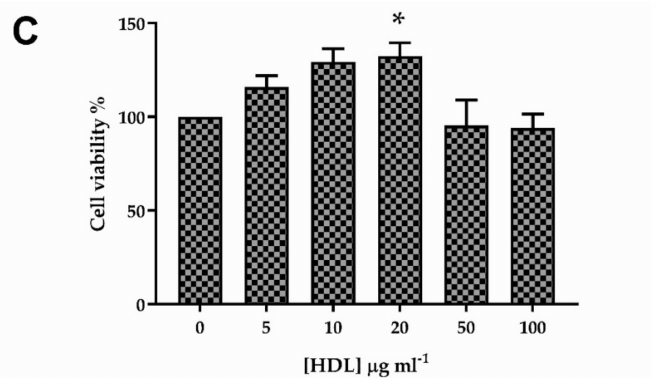
Figure 1. The effects of treatment (24 h) with HDL (0–100 µ g mL − 1 ) on the conversion of MTT to formazan by HKn, HDFn and HDFa are shown in ( A – C ), respectively; data in each figure are the mean ± SEM of three independent experiments, each performed using six replicates. The data were analysed using one-way ANOVA and Dunnett’s post-hoc test; * p < 0.05.